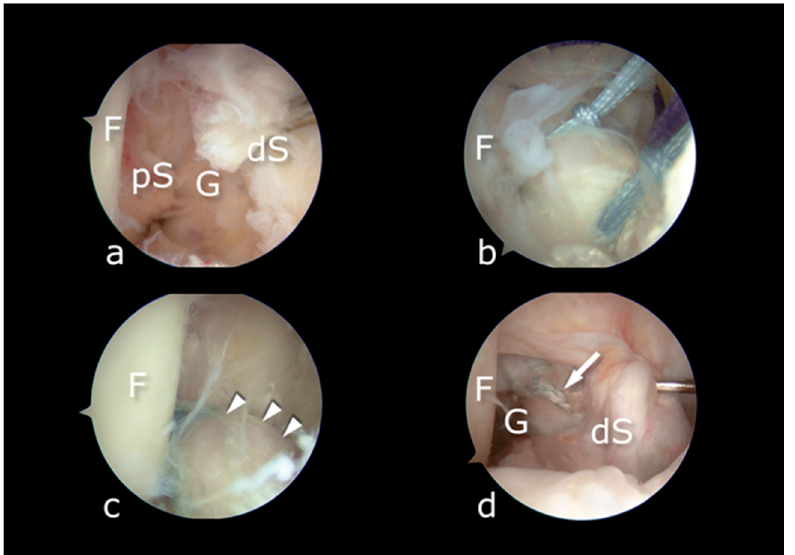
Figure 7. ( a ) Primary ACL repair. Distal stump (dS) is waving in front of the intercondylar notch of the femur (F). Proximal stump (pS) is visible. ( b ) The stump is sutured by two closed-loop FiberLink sutures and retracted from the femoral bone (F). ( c ) After completion of the procedure, the tension of the repaired ACL (arrowheads) and FiberTape is checked. ( d ) Revision surgery. Re-rupture of the construct is visible with gap (G) opening. Distal stump is folding and hook traction reveals FiberLink sutures (arrow).